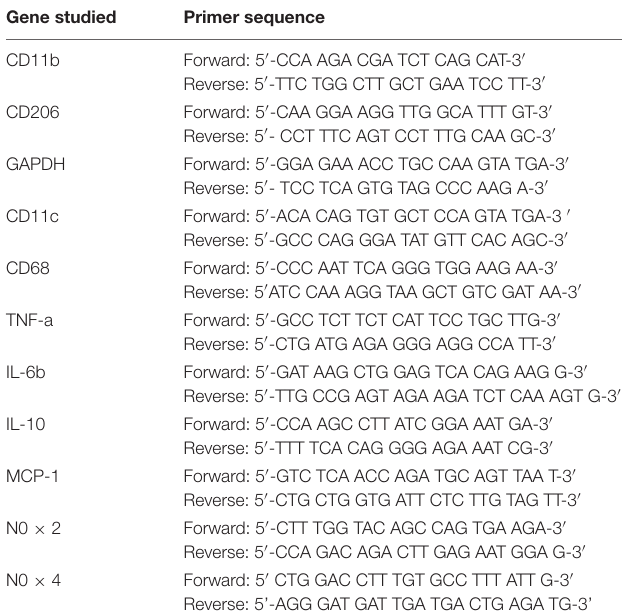
TABLE 1 | Sequences of primers used in this